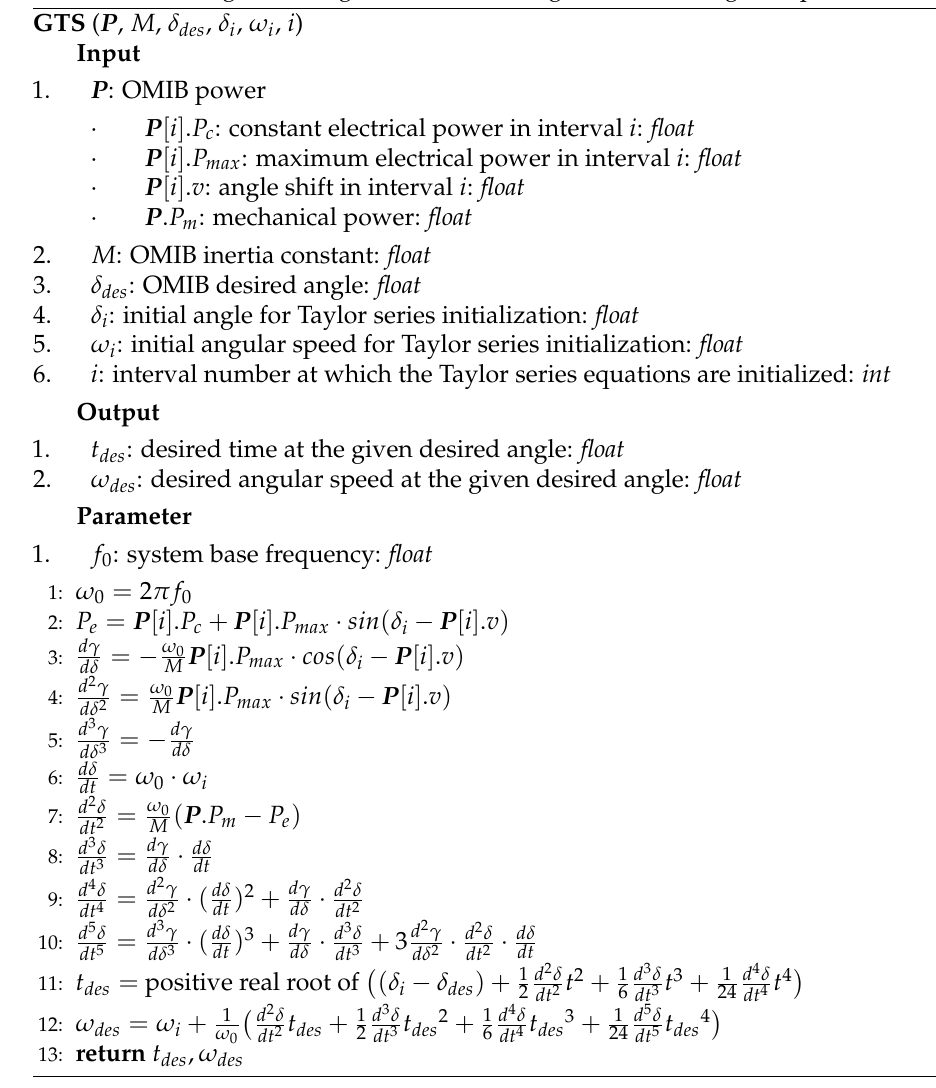
Algorithm A9 Global Taylor series to find the OMIB time and angular speed associated with a desired angle, starting from an initial angle, time and angular speed